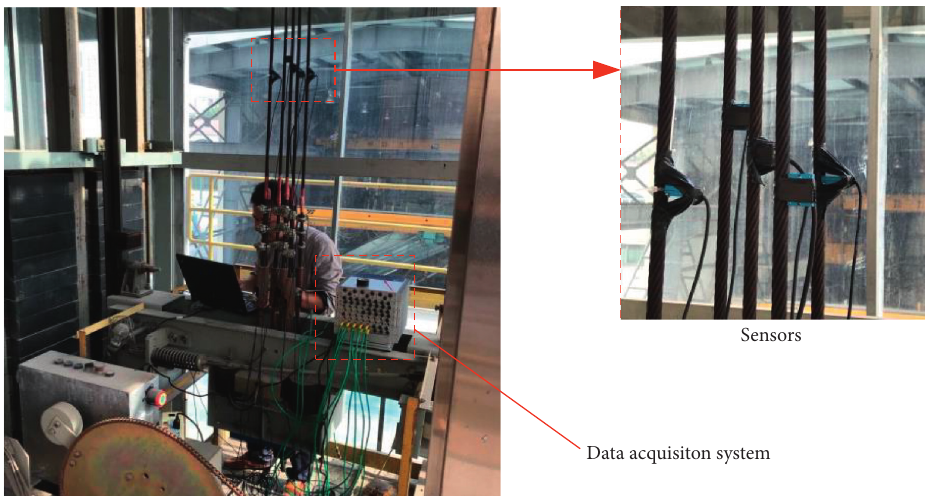
Figure 8: Arrangement of sensors and equipment on the hoist rope.